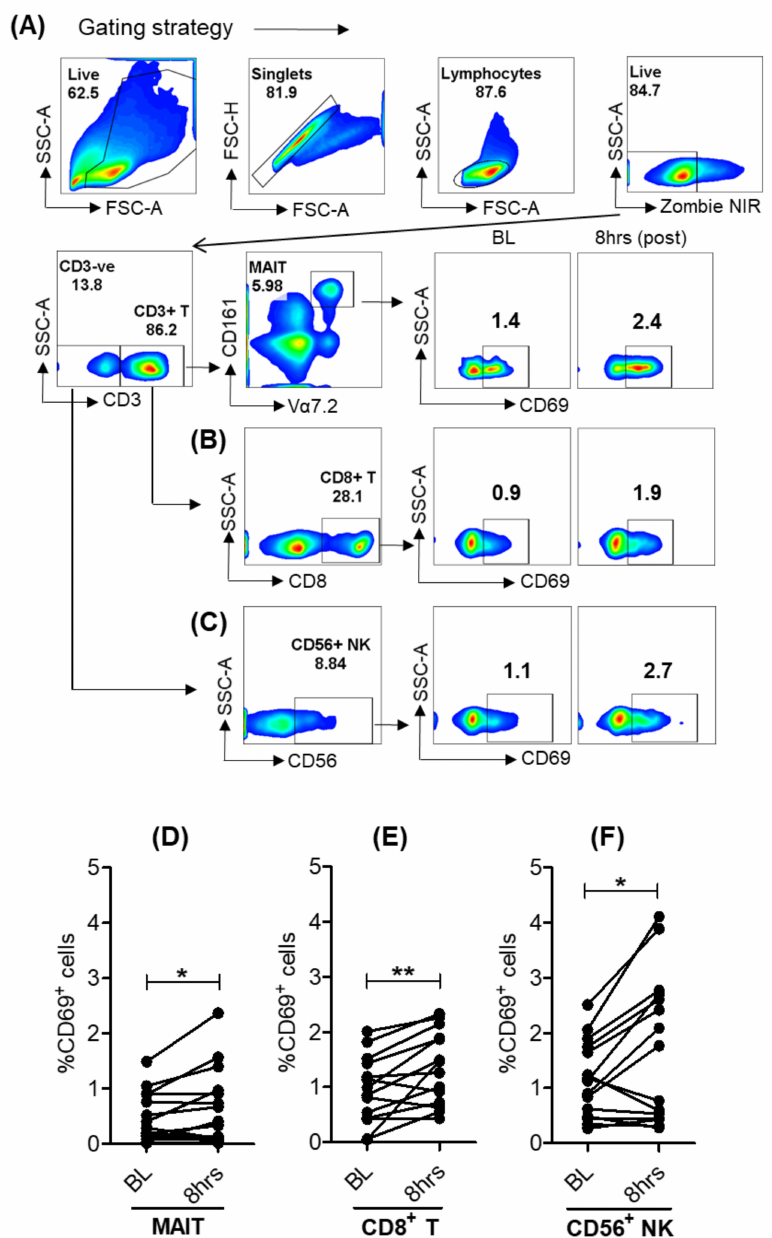
Figure 5. Activation of lymphoid cells after oral-SLGN treatment in CHB subjects. Gating strategy and cell surface expression of CD69 on ( A ) MAIT, ( B ) CD8 + T and ( C ) CD56 + NK cells. Comparative analyses of frequencies of CD69 on ( D ) MAIT, ( E ) CD8 + T and ( F ) CD56 + NK from baseline and 8 h samples in SLGN-treated (3.0 mg dose, n = 14) CHB patients. Significance was calculated by a two-tailed paired Student’s t test, and p value ≤ 0.05 * and 0.01 ** show grades of